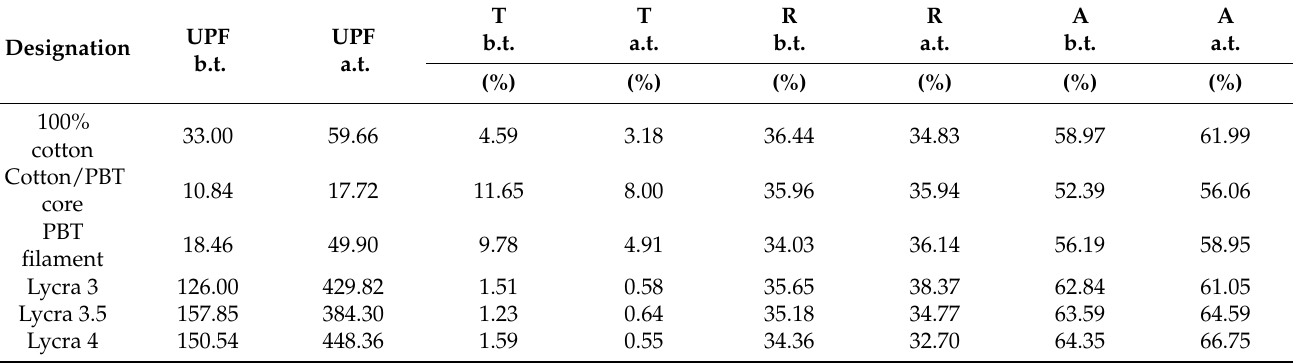
Table A5. Selected UV properties of samples before treatment (b.t.) and after treatment (a.t.).